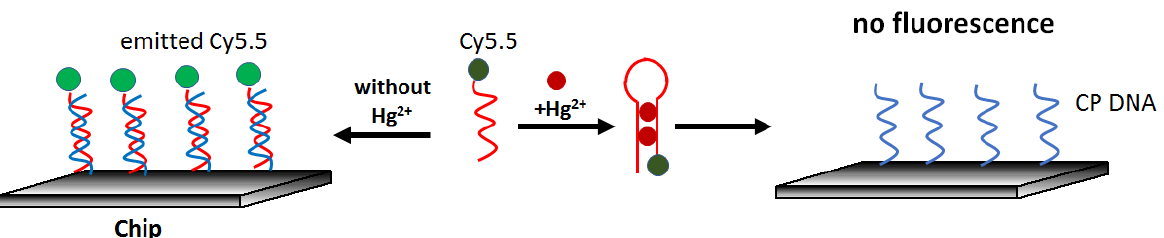
Figure 11. Schematic diagram of the waveguide-based aptasensor for the determination of Hg 2+ by means of fluorescence turn-off due to the blocking hybridization of fluorescent probe by mercury ions.